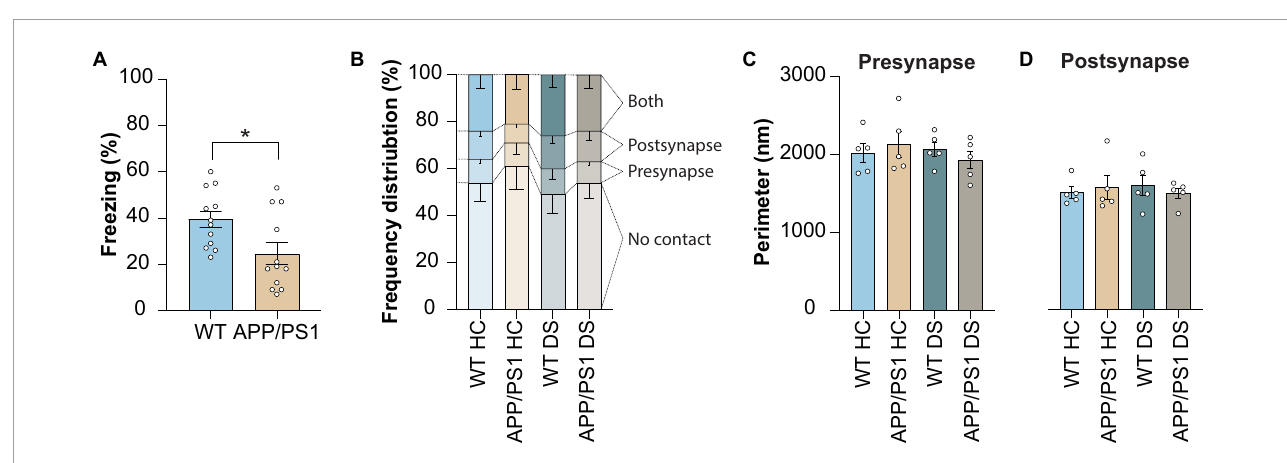
FIGURE2 Contextual memory formation induced by delayed shock in WT and APP/PS1 mice does not affect the proportion of astrocyte-synapse contact or synapse size. (A) Freezing levels measured during contextual fear conditioning in WT and APP/PS1 mice at 3 months of age. (B) Frequency distribution plot of contact categories at 4 months of age. (C) Pre-synapse perimeter at 4 months of age. (D) Post-synapse perimeter at 4 months of age. Data is presented as mean ± SEM. * P = ≤ 0.05. (A) WT n = 12, APP/PS1 n = 12; (B) WT HC n = 5/441, APP/PS1 HC n = 5/376, WT DS n = 431, APP/PS1 DS n = 5/438; (C,D) WT HC n = 5/459, APP/PS1 HC n = 5/376, WT DS n = 5/431, APP/PS1 DS n = 5/438. Statistical details are reported in Supplementary Table 1